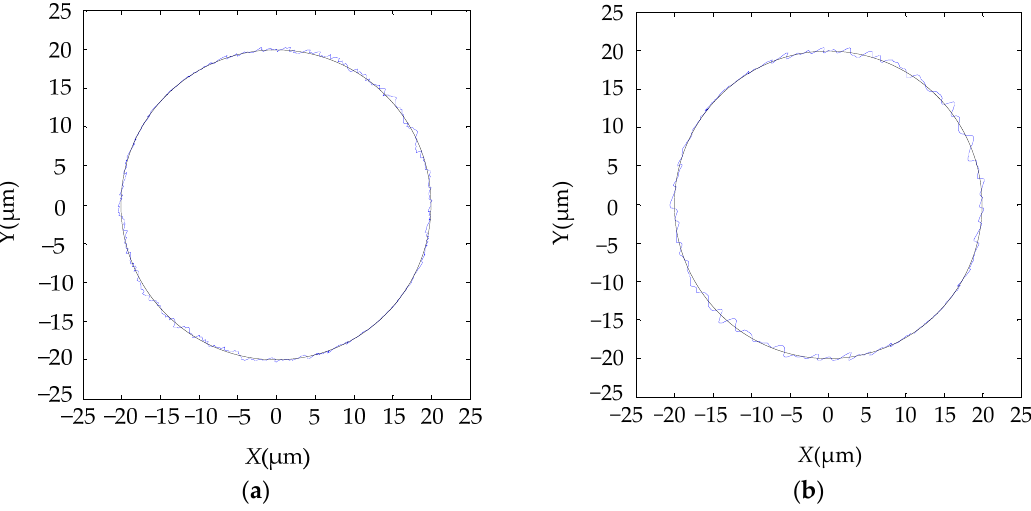
Figure 10. Circle trajectory tracking analysis: ( a ) proposed control model; ( b ) traditional PID control model.